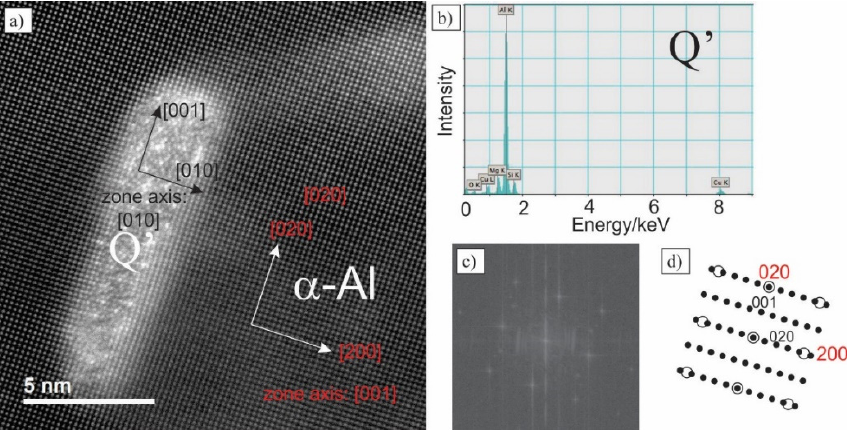
Figure 13. A Q ′ -precipitate. ( a ) The high resolution TEM micrograph of the Q ′ - precipitate in α -Al, ( b ) EDS-spectrum, ( c ) FFT of the HR-TEM micrograph, ( d ) model of FFT (Open circles: α -Al, black dots: Q ′ -precipitate.